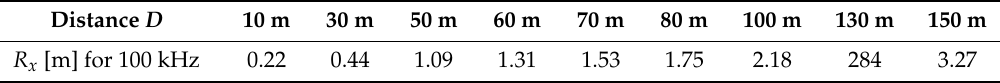
Table 4. Calculated along-track resolution of the ACSON-100 side-scan